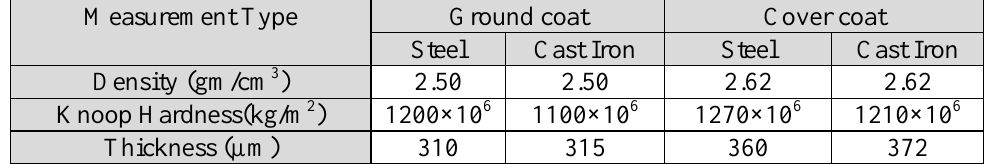
Table 6: Density, hardness and thickness of the coating enamel layer on the steel and cast iron without the addition of antimony oxide.